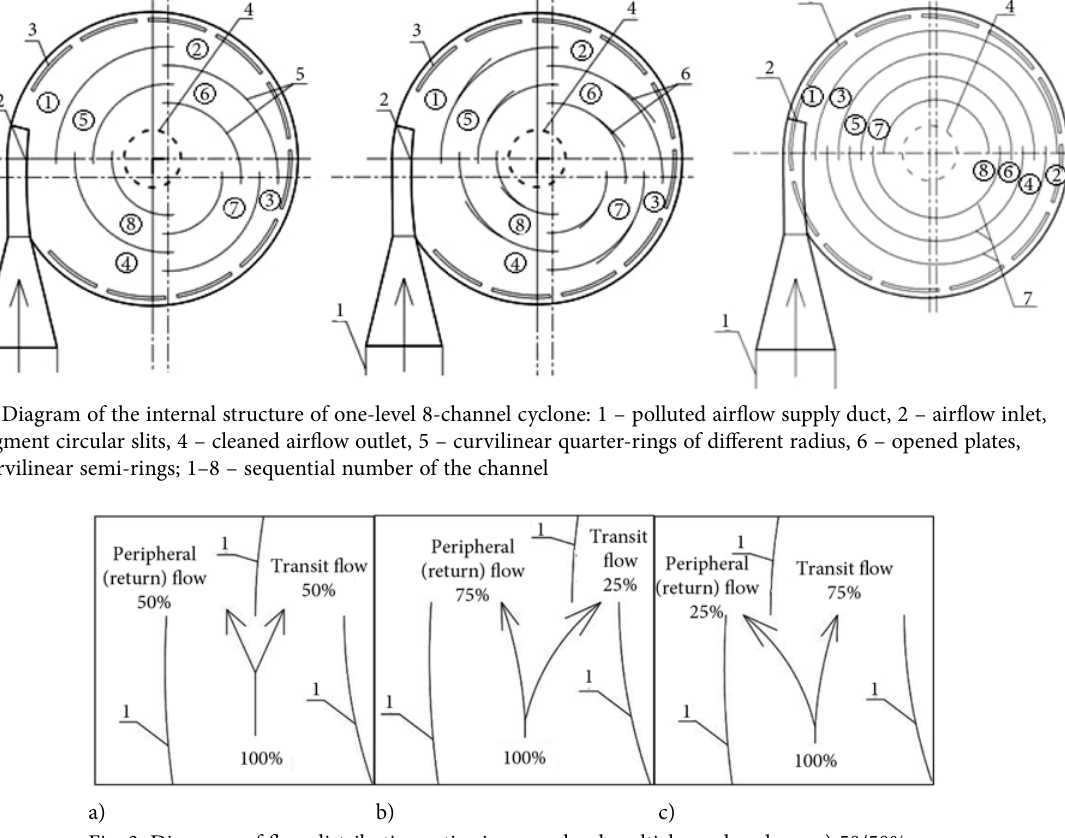
Fig. 3. Diagrams of flow distribution ratios in a one-level multichannel cyclone: a)